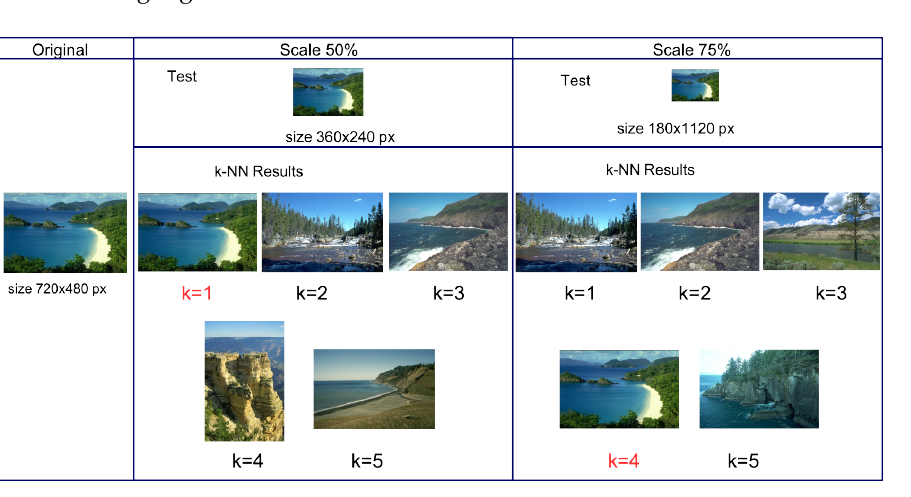
Figure 8. Test with scaled images down to 50% and 75%. Table 3. Confusion matrix for scale, rotation, and noised images (the same